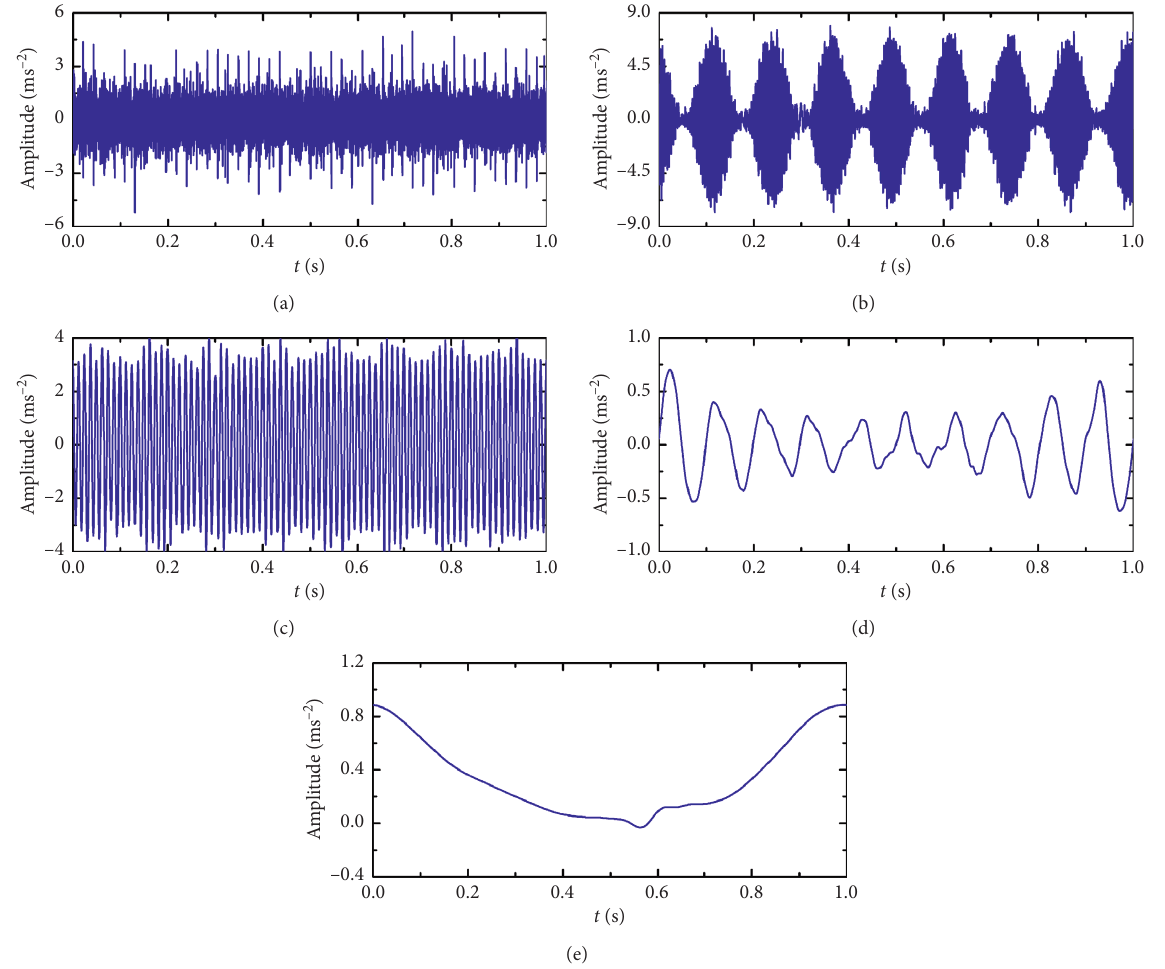
Figure 6: The decomposed IMFs using the ALIF: (a–e) IMF1–IMF5.